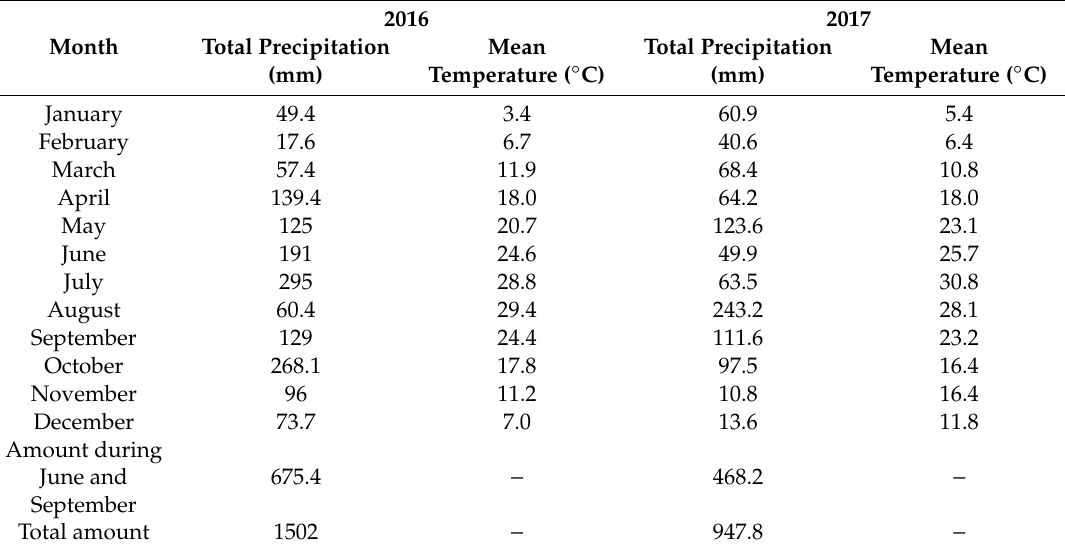
Table 1. The monthly distribution of precipitation and mean temperature in 2016 and 2017.